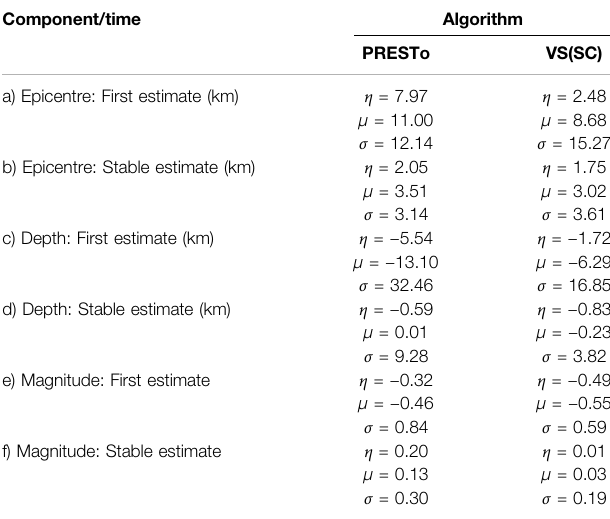
TABLE4| Median( η ),mean( μ ),andstandarddeviation( σ )oftheerrordistributions shown in Figure 6 .